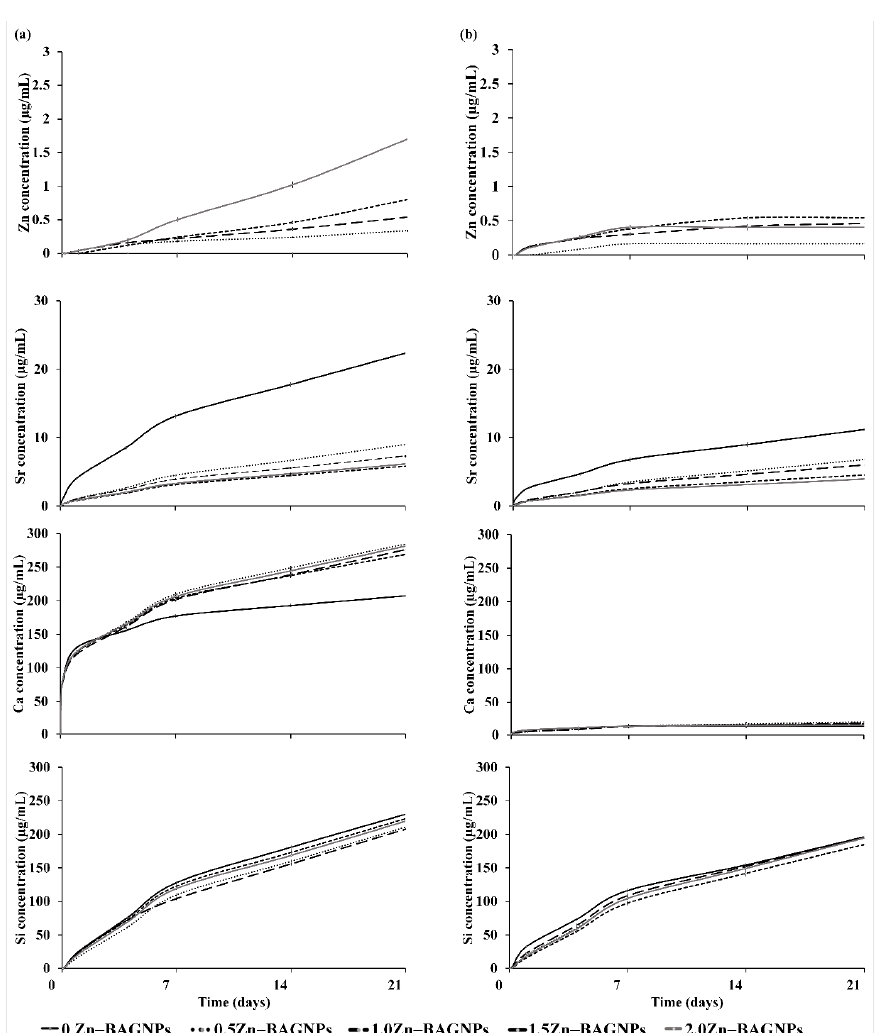
Figure 6. Dissolution profiles of Si, Ca, Sr, and Zn as a function of time for Zn-BAGNPs ( a ) SBF solution pH 7.4 and ( b ) PBS solution pH 7.4.